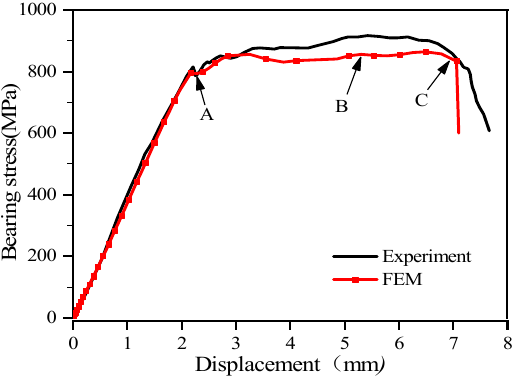
Figure 5. Stress ‐ displacement curves of thin ‐ layer composite material single ‐ lap structures. Figure 5. Stress-displacement curves of thin-layer composite material single-lap structures. Figure 5 gives stress ‐ displacement curves of single ‐ lap thin ‐ ply ‐ laminated compo ‐